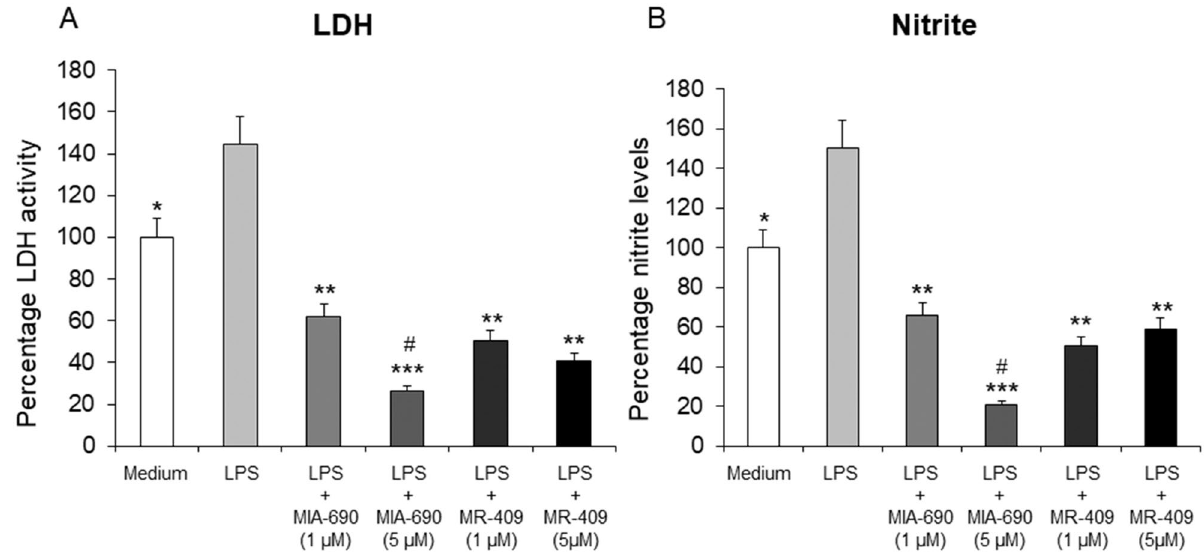
Figure 2. Inhibitory effects of MIA-690 (1 and 5 μM) and MR-409 (1 and 5 μM) on LDH activity ( A ) and nitrite production ( B ), ex vivo (n = 5 for each group of treatment). Data are expressed as means ± S.E.M. and analyzed by analysis of variance (ANOVA) followed by Bonferroni post-hoc test * p < 0.05, ** p < 0.01, *** p < 0.005 versus LPS; # p < 0.05 versus treatment with MR-409.